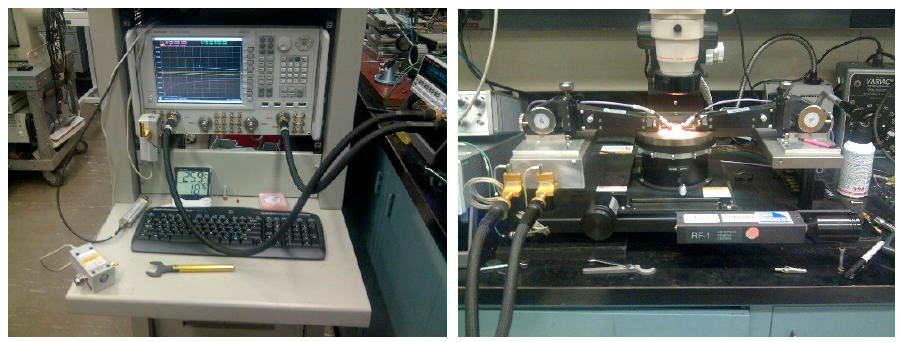
Figure 3. Measurement setup at NRL.